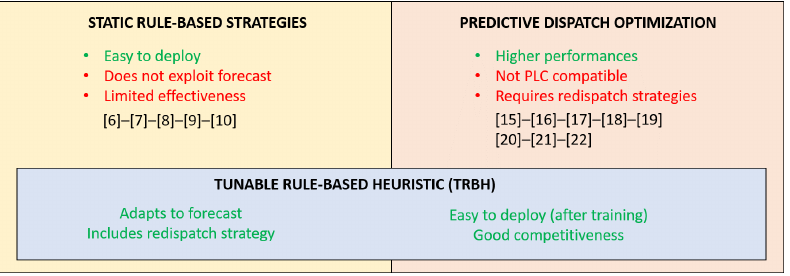
Figure 1. Comparison summary among the different strategies under consideration.